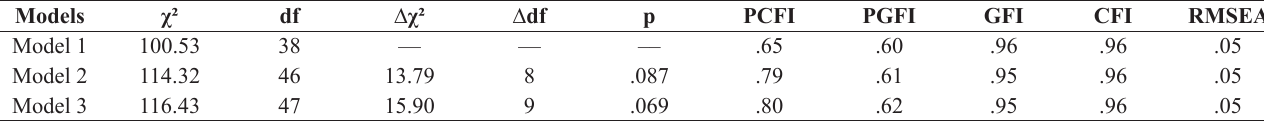
Table 4. Results of the multi-group analysis across the first and second application of the PSRQ.